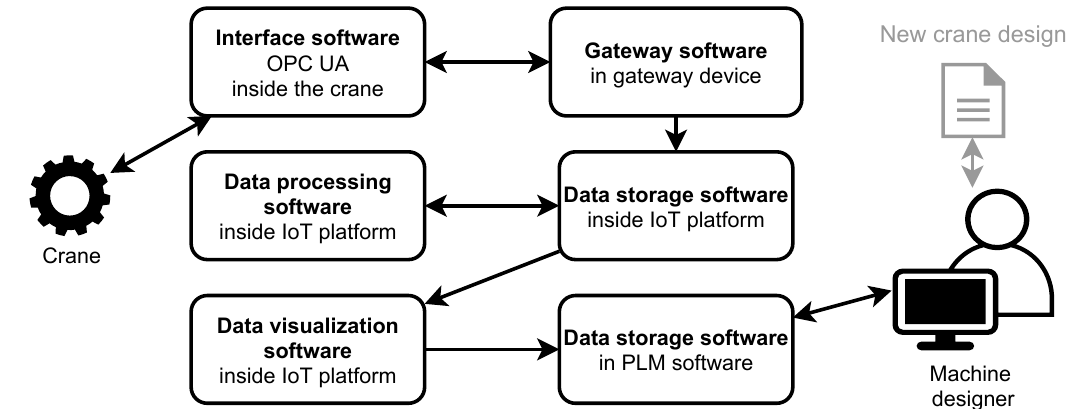
Figure 5. The data flow of the bearing lifetime estimation case. Designing a new crane is the purpose of providing the data, but not implemented during this